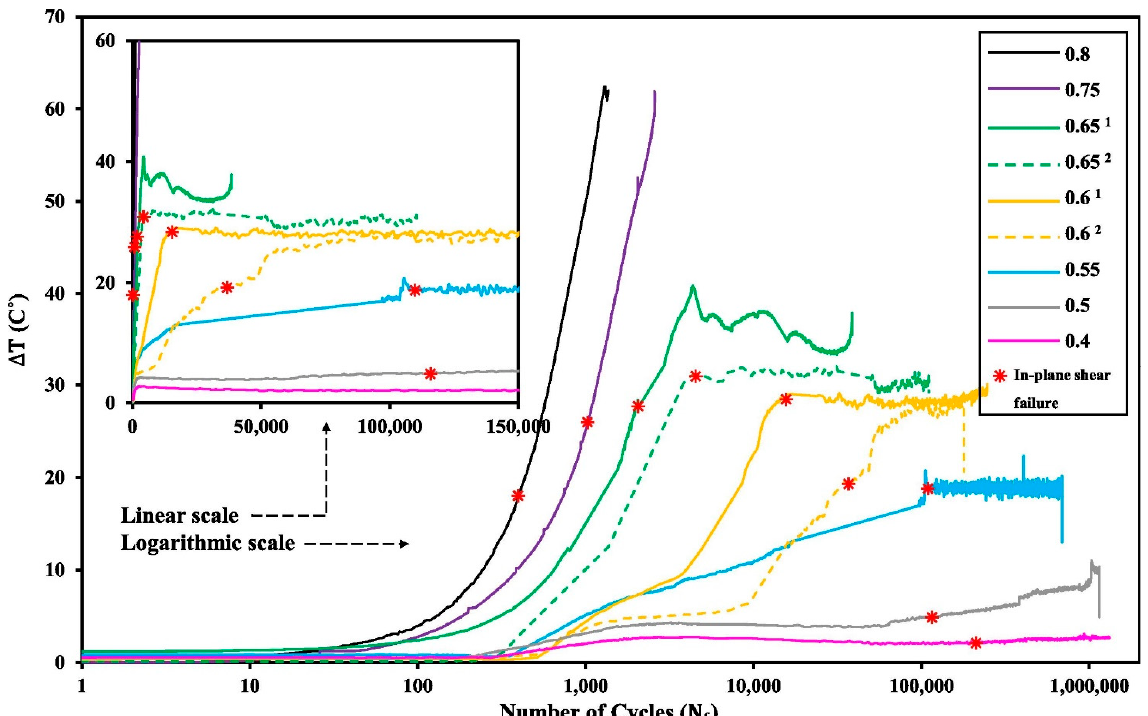
Figure 23. An exemplary plot of temperature evolution vs. stress alteration for the angle-ply [±45] 2 s CFRP composite, adapted with permission from Ref. [91]. Copyright © 2022 Elsevier